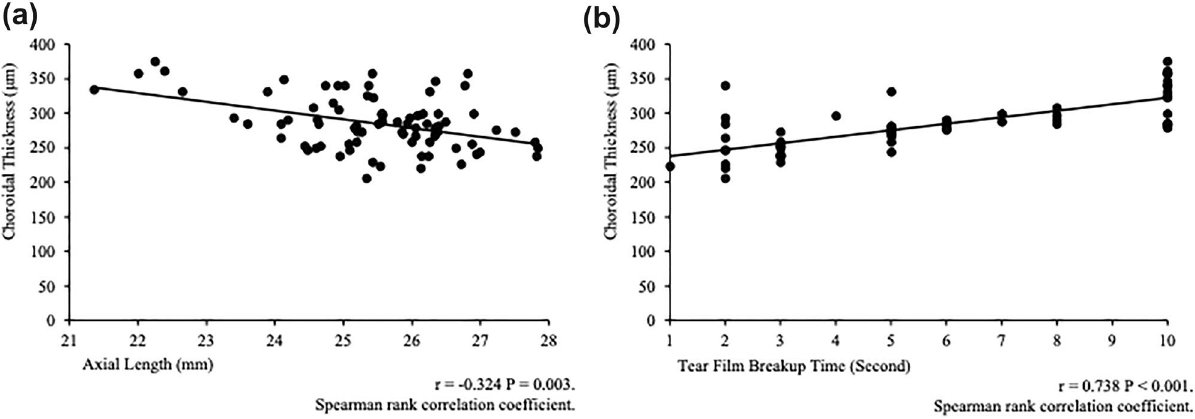
Figure 1. The correlations between the choroidal thickness (CT) and the tear film breakup time (TBUT) and axial length (AL). ( a ) The correlations between the CT and the TBUT; and ( b ) the CT and the AL. The Spearman rank correlation coefficients and P values are shown between the CT and the TBUT and between the CT and the AL. Significant correlations are seen between the CT and the TBUT and